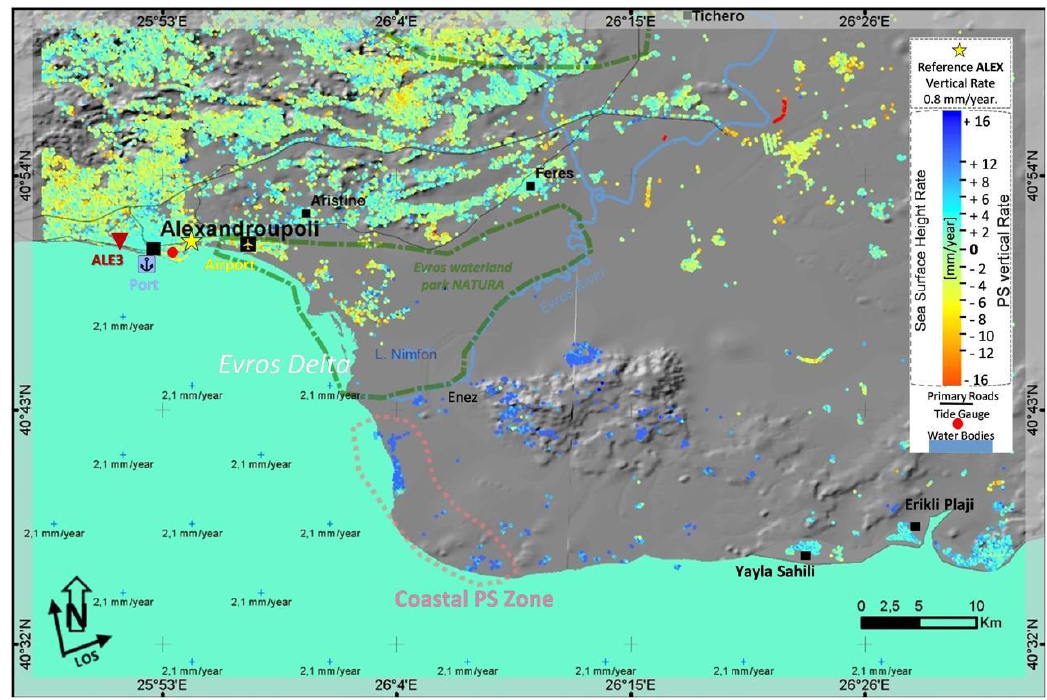
Figure 3 . Vertical land deformation rate and sea-surface height rate map of Alexandroupolis, Evros Delta, both represented with the same color scale. Coastal permanent scatterers (PSs) are bounded with a red dashed line. The Global Navigation Satellite System station ALE3 and tide gauge, respectively, used in validation are depicted with reversed red triangles and red circles.